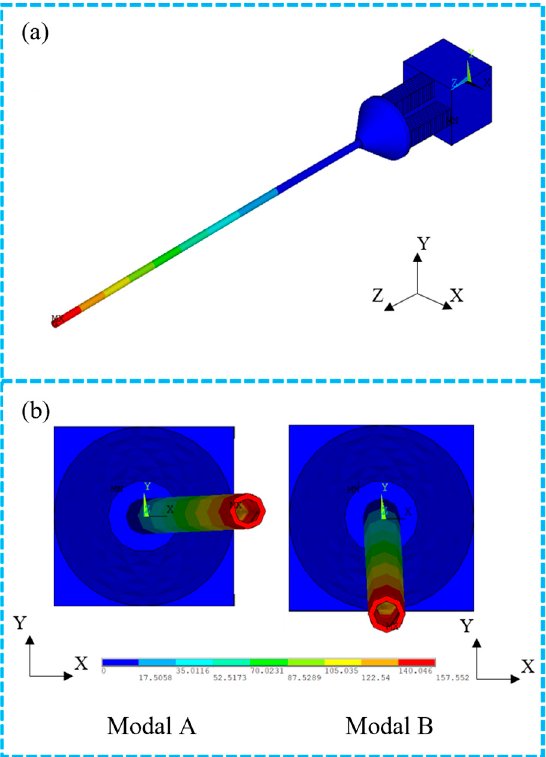
Figure 6. Modal analysis results of the scanner. ( a ) Bending vibration of the cantilever beam. ( b ) Two orthogonal modals (A and B) calculated by modal